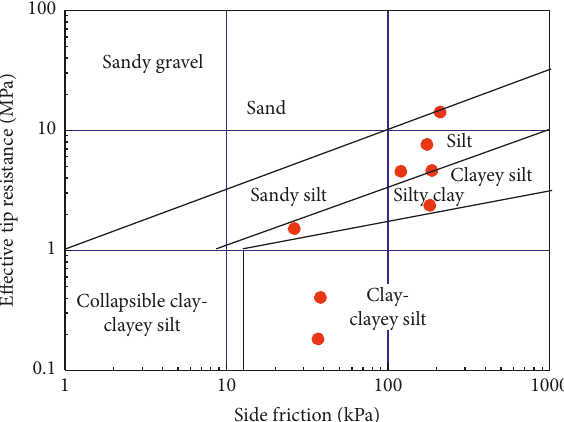
Figure 7: Soil classification using the method of Eslami and Fellenius [39].